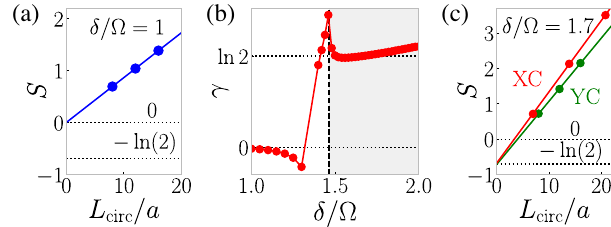
FIG. 4. Topological entanglement entropy. We determine the offset γ in the area law S ¼ α L − γ [27,28,114,115]. (a) For the trivial phase, this value is zero. (b) As we increase δ = Ω , we enter the spin liquid where γ ≈ ln 2 . Here, we plot S L S L ¼ n is the bipartition entanglement entropy for the XC- geometry. (c) For an exemplary point in the spin liquid, we extract γ for two distinct geometries (up to XC-12 and YC-8). Note that XC- n (YC- n ) has circumference L